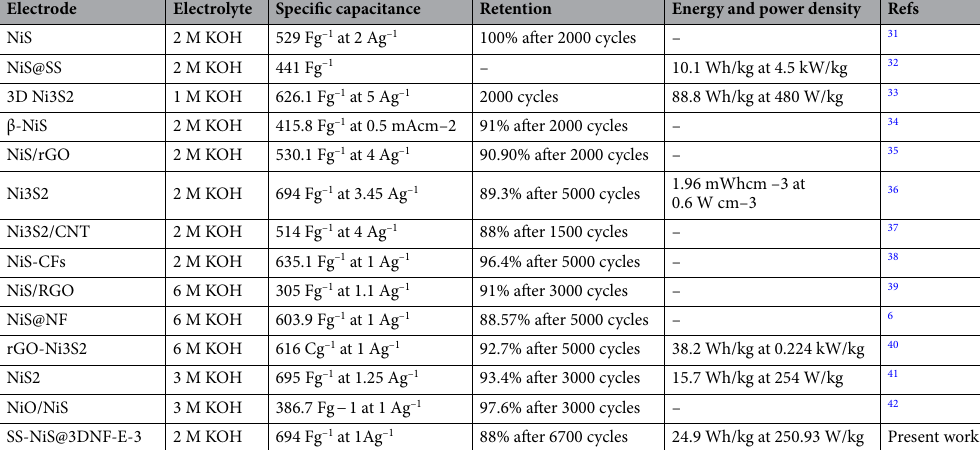
Table 1. Comparison of the specific capacitance, energy density and power density of the SS-NiS@3DNF-E-3 electrode with those of other reported nickel sulfide-based electrode materials.